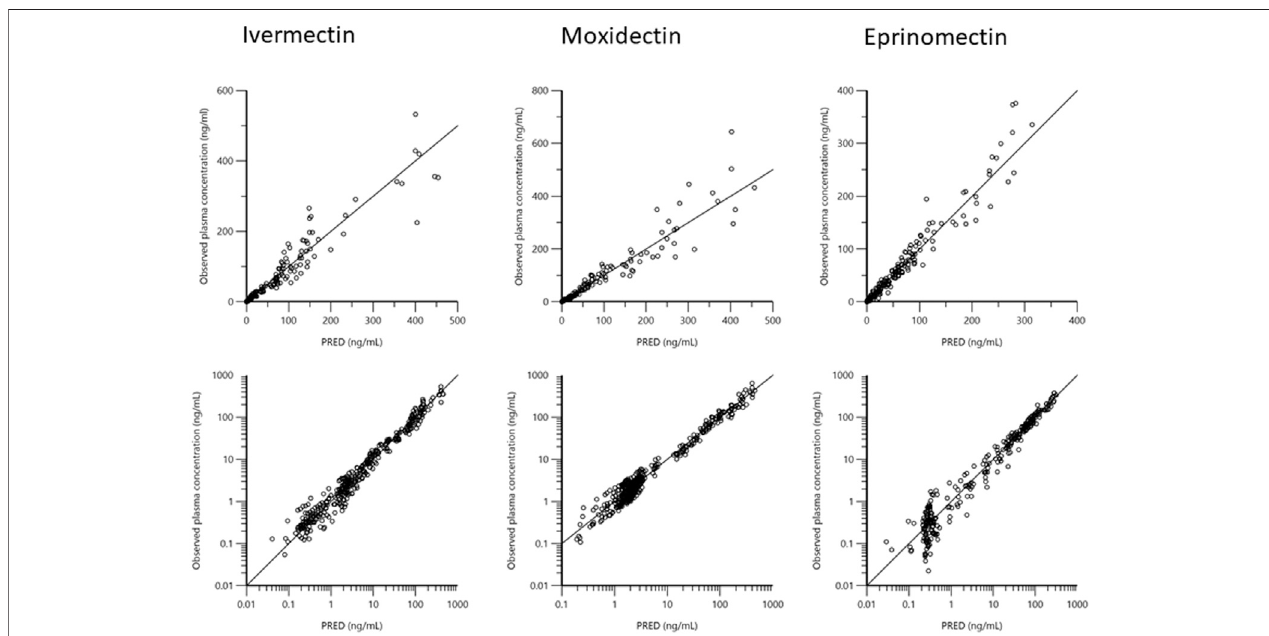
FIGURE 4 | Plots of the dependent variable i.e. of observed plasma concentrations (ng/mL) vs. population predicted plasma concentrations (PRED) (no random component) for the three drugs. The plots illustrate observed vs. fi tted values of the model function. Ideally they should fall close to the line of unity y (cid:1) x . Arithmetic scale (upper) and logarithmic scale (lower) . For both arithmetic and logarithmic scales, data are evenly distributed about the line of identity, indicating no major bias in the population component of the model.